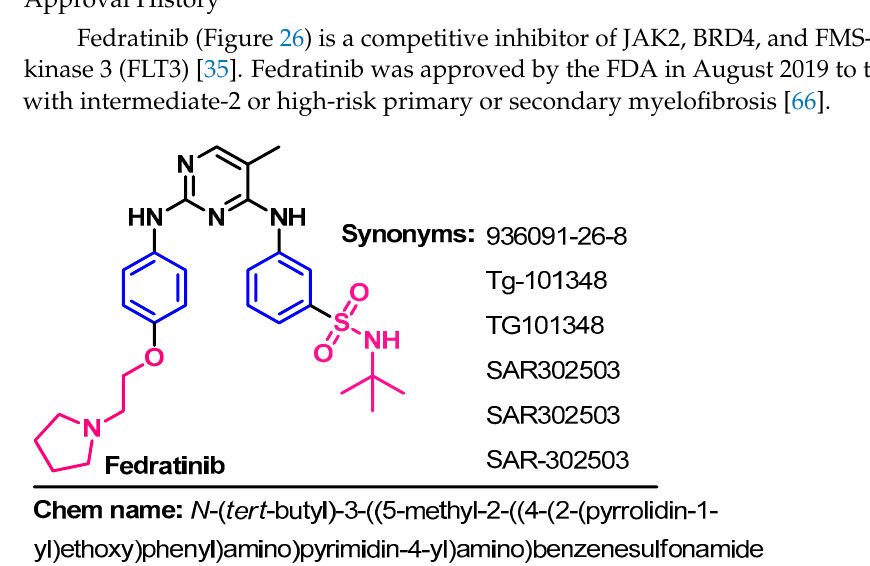
Figure 26. Chemical structure/name/synonyms of fedratinib.